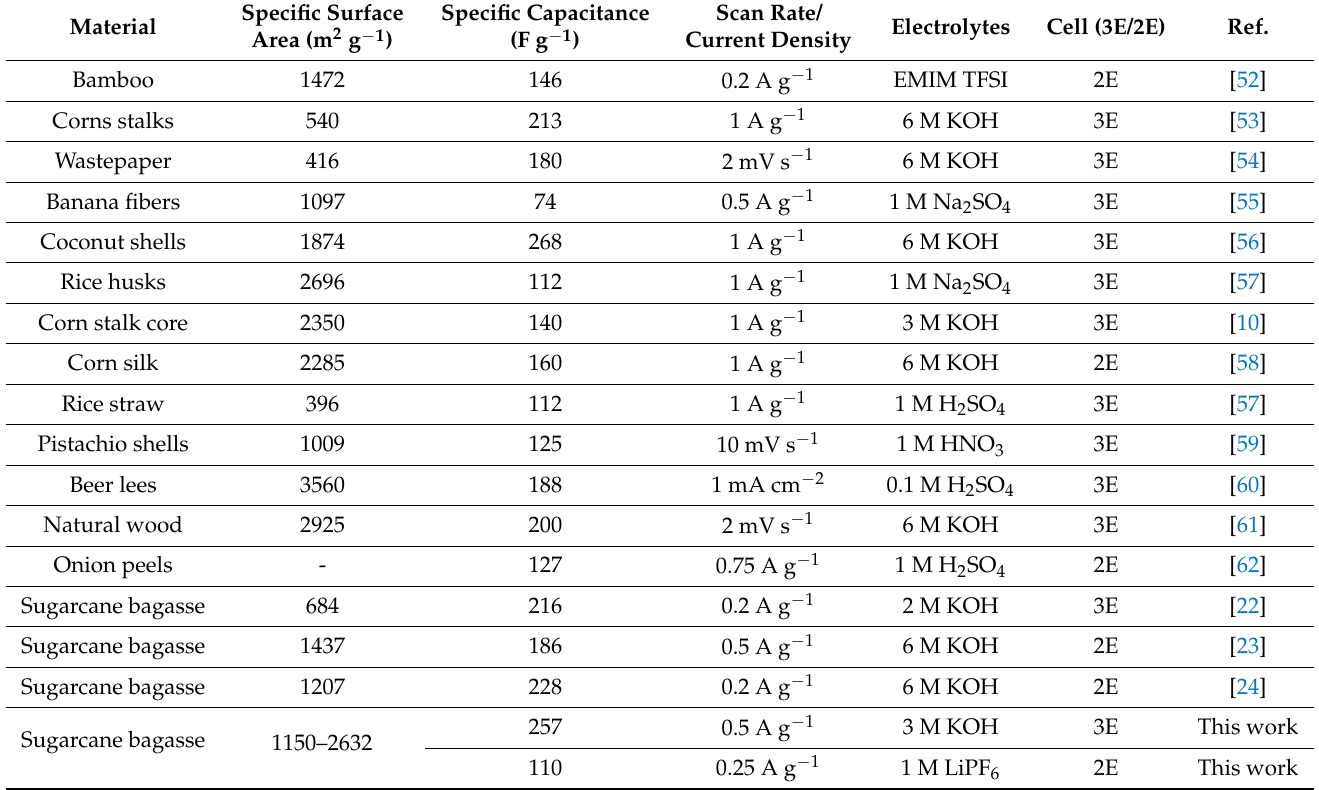
Table 3. Comparison of the properties of various biomass-derived carbon sources used in